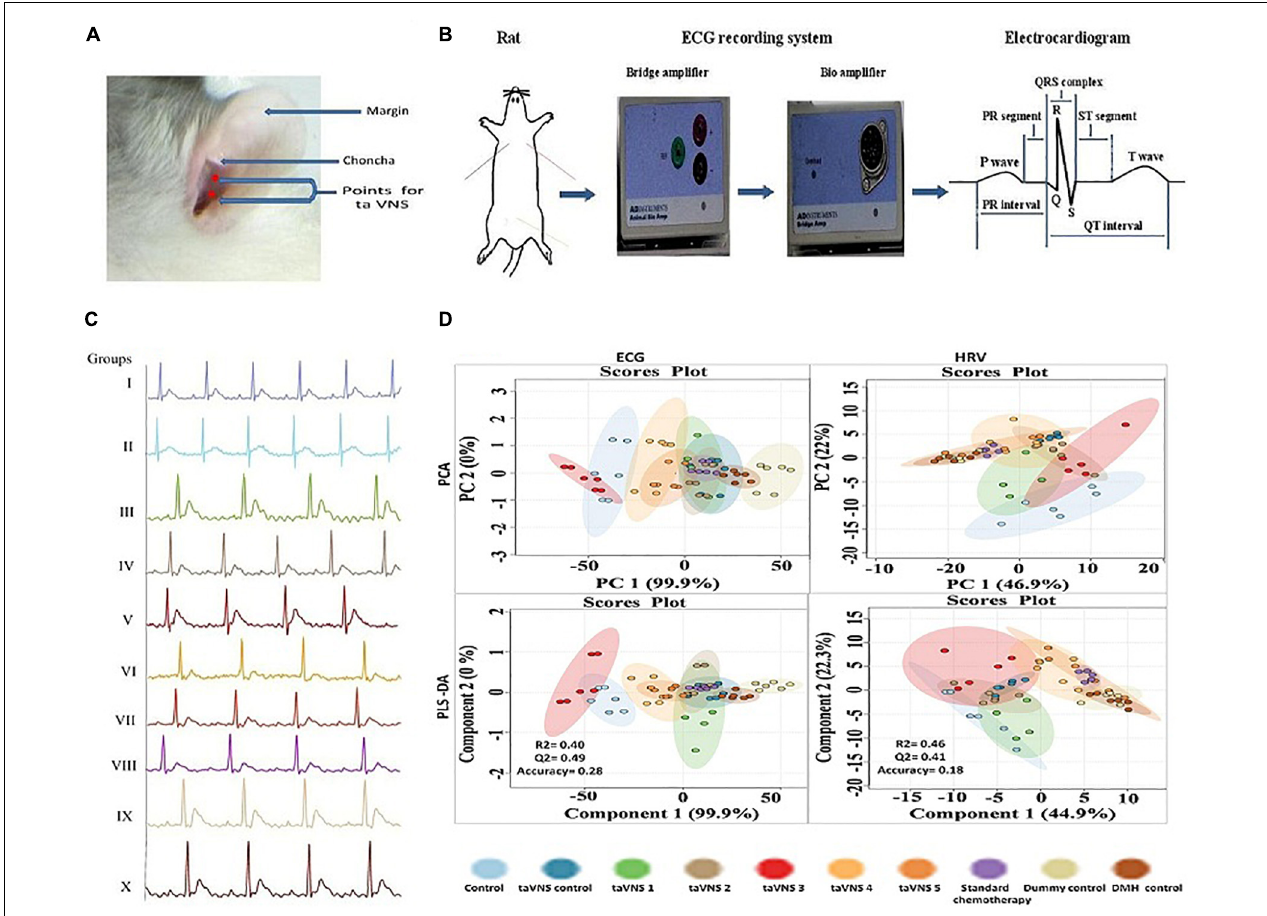
FIGURE 1 | Stimulation, recording, and analysis of the ECG recordings. (A) Locations of stimulation points on rat’s auricular surface for taVNS. The auricular choncha is the region of the ear where a major transcutaneous distribution of vagus nerve occurs. The stimulation points for taVNS are located in this region. (B) Placement of electrodes and recording of ECG in experimental animals. (C) Representative ECG recordings of control, DMH, and taVNS treatments. (D) The figure represents for 2D score plots derived from PCA and PLS-DA based analysis for ECG and HRV signals in different